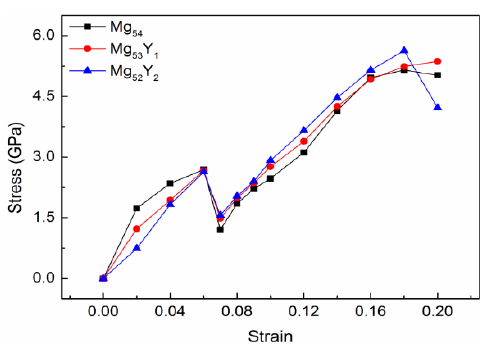
54 , Mg 53 Y 1 and Mg 52 Y 2